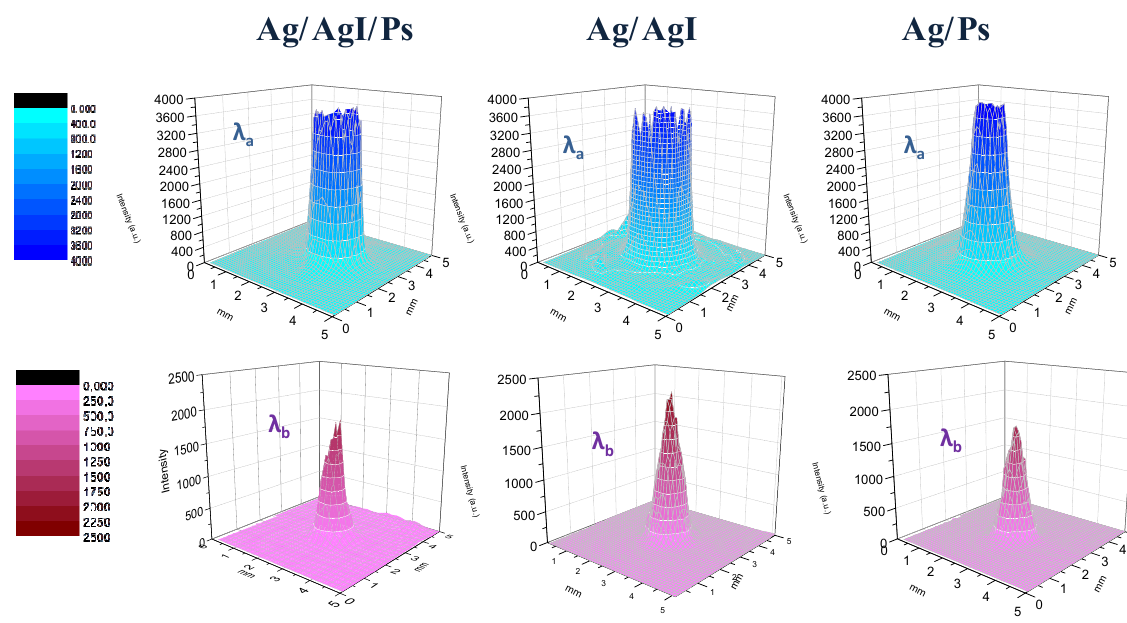
Figure 4. Far-Field spatial intensity distribution of the λ upon exiting a 12 cm long and 1 mm core diameter hollow waveguide having AgI/Ps double dielectric layer and having a single dielectric film of AgI and Ps. The beam profiles have been measured by focusing the QCL beam directly at the center of waveguide by using a ZnSe lens.